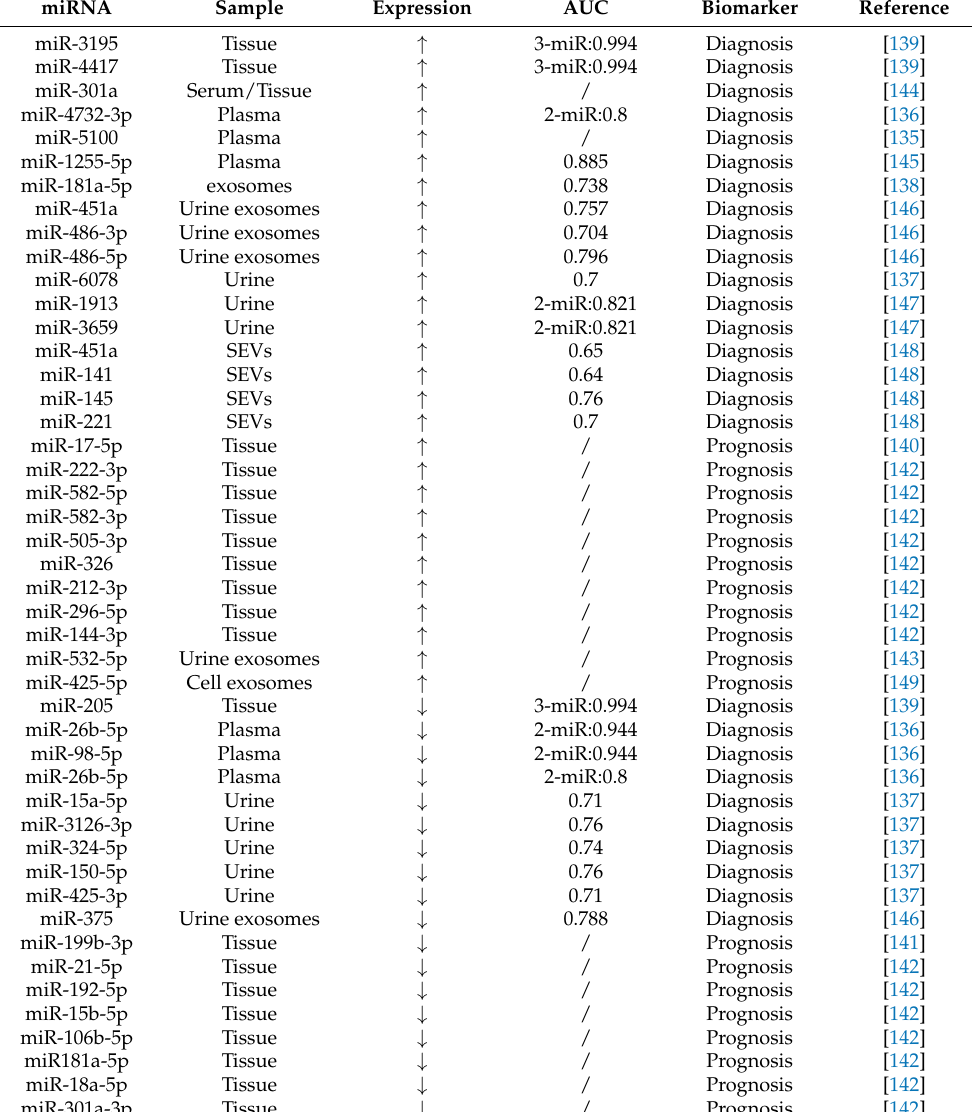
Table 6. MicroRNAs as biomarkers for diagnosis and prognosis of PCa. miRNA